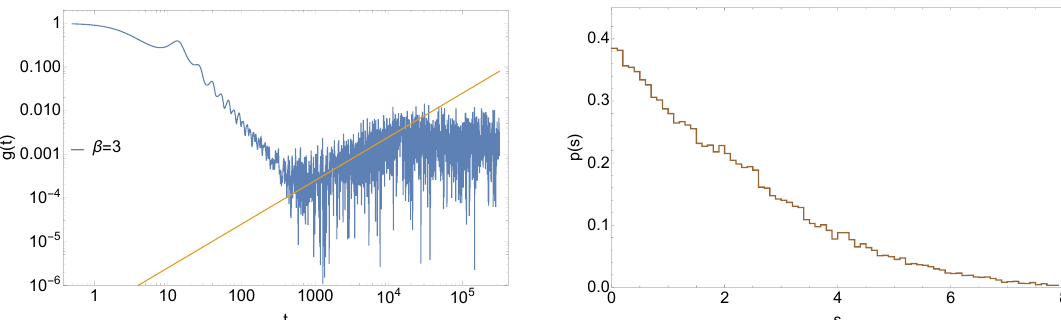
Figure 5. SFF (left) and its corresponding level spacing (right) for BTZ black hole normal modes with z = 12 , n = 270 and J = 200 at β = 3 . The yellow line has slope 1. 0 cut cut